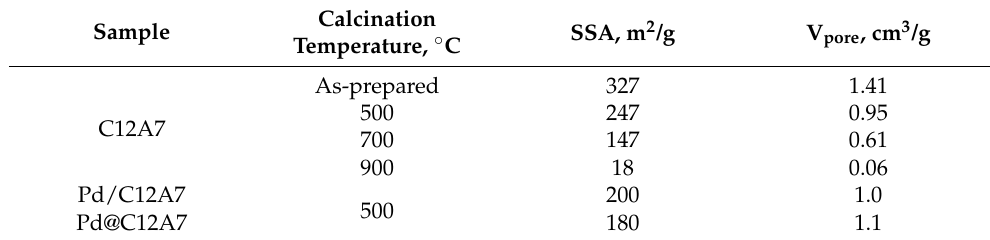
Table 1. Textural characteristics of pure and Pd-containing C12A7